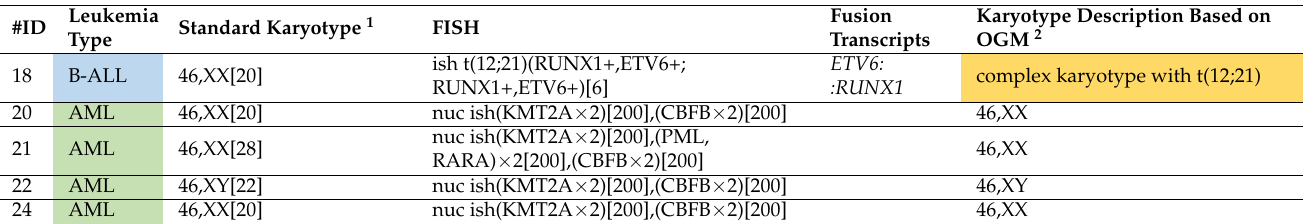
Table 2. Detailed results of standard testing versus OGM for 24